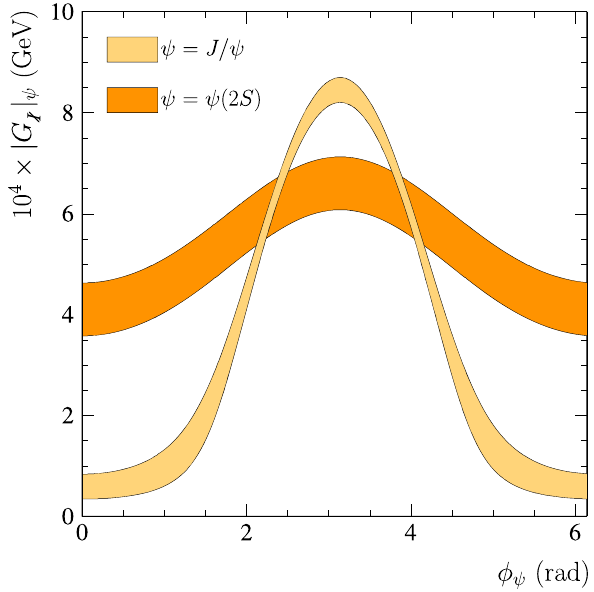
Fig. 3 Modulus of the isospin-violating amplitude of the J /ψ meson, light-orange band, and of the ψ( 2 S ) , dark-orange band, as a function of the phase relative to the EM amplitude D